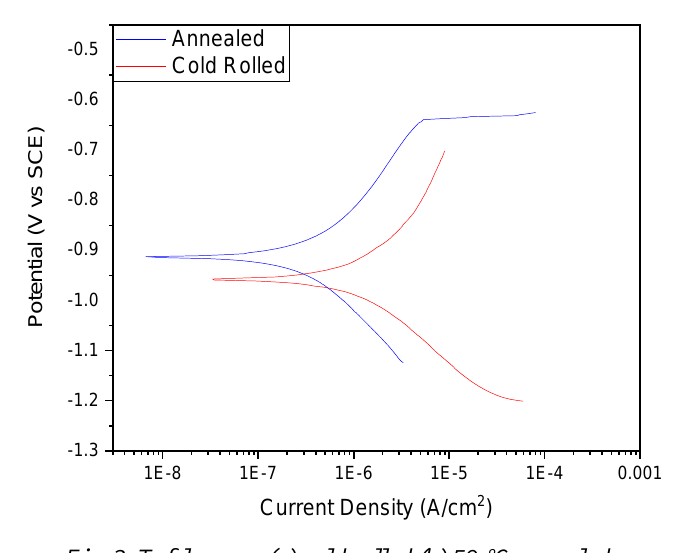
Fig. 3. Tafel curves (a) cold rolled (b) 50 °C annealed. Table 3. Corrosion Rate of AA5083 alloy at Different